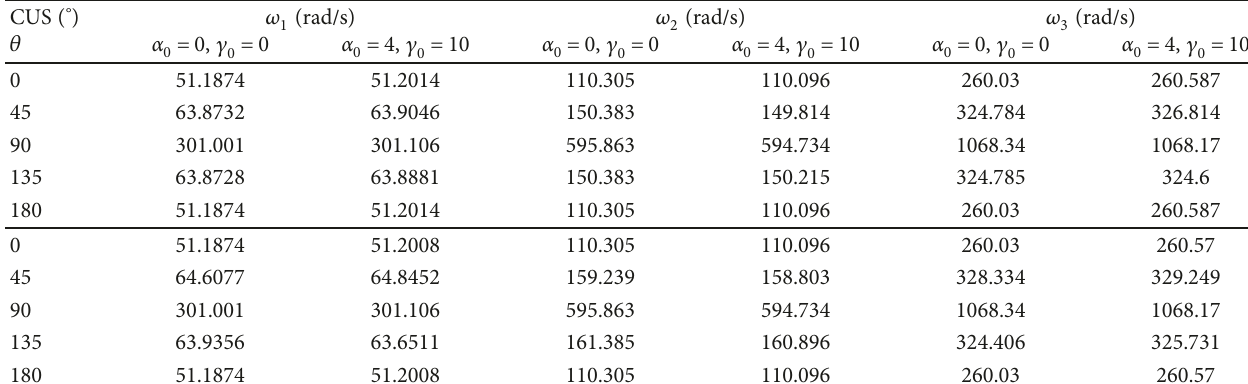
= 0 and γ = 0 for CUS and CAS. 0 0